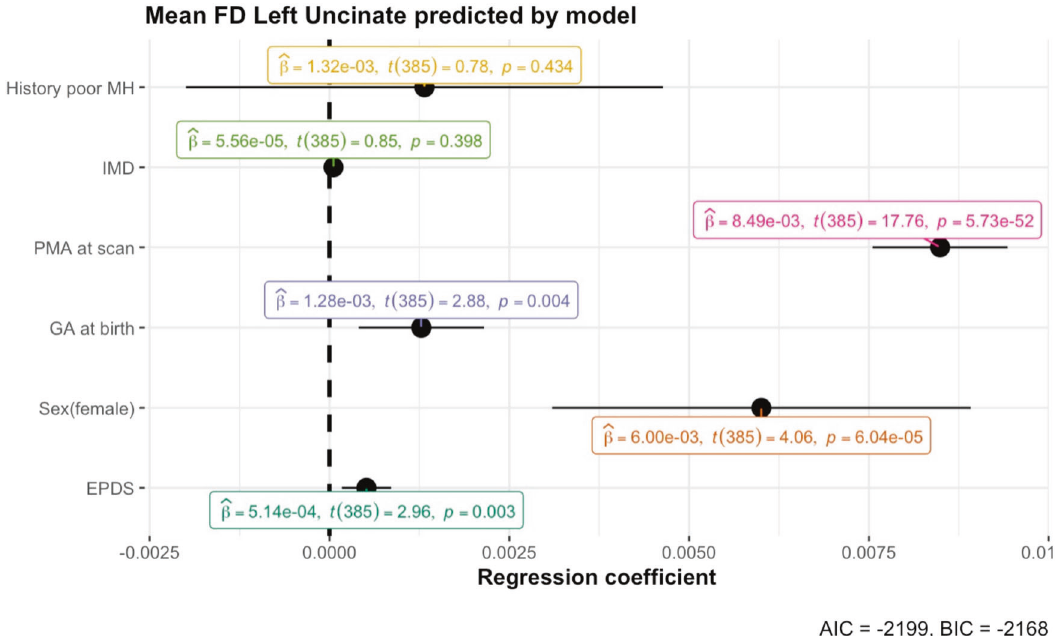
Fig. 3 Dot-and-whisker plot for the multiple linear regression model predicting mean FD in the left uncinate fasciculus. The black dots represent the regression coef fi cient estimate with 95% con fi dence intervals. The caption contains Akaike ’ s Information Criterion (AIC) and the Bayesian Information Criterion (BIC), with smaller values indicating a better fi t. For a model without EPDS, the AIC is − 2193 and BIC is − 2165, indicating a worst fi